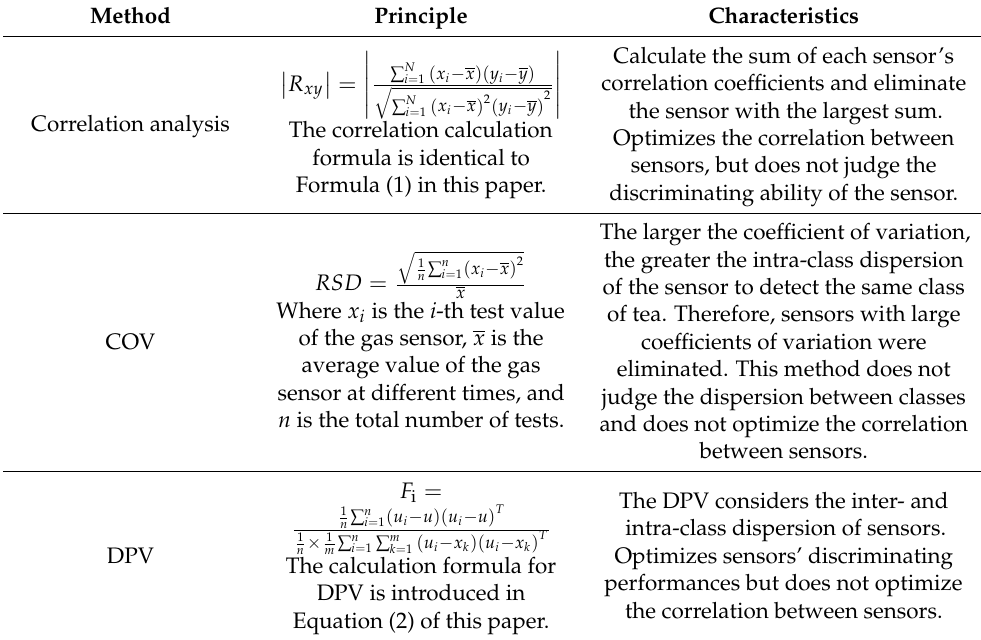
Table 11. Comparison of correlated sensor analysis and elimination